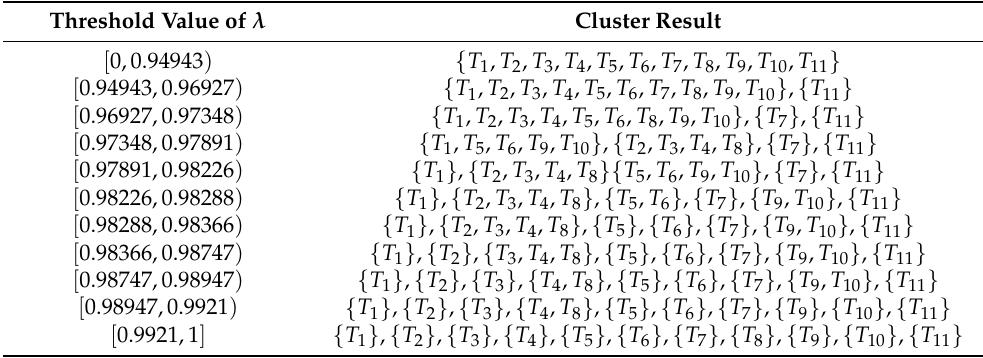
Table 3. Cluster results of maximal tree method.